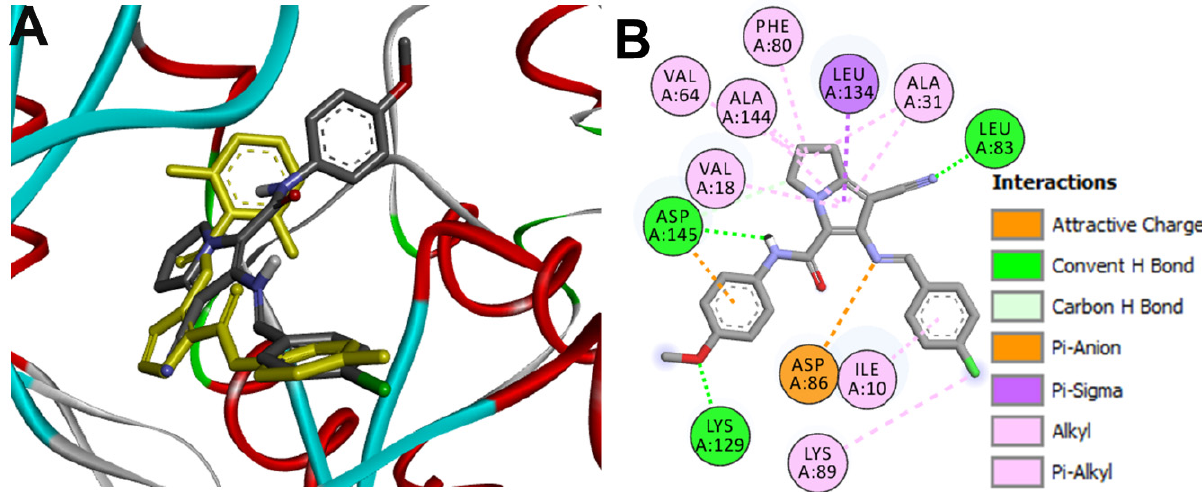
Figure 19. Binding mode of compound 16g (shown as sticks colored by element) into CDK2 (pdb: 2VTP): ( A ) 3D binding mode of the top-ranked pose of compound 16g overlaid with the co-crystallized ligand, LZ9 (yellow sticks); ( B ) 2D binding mode of compound 16g showing different types of interactions with amino acids in CDK2.